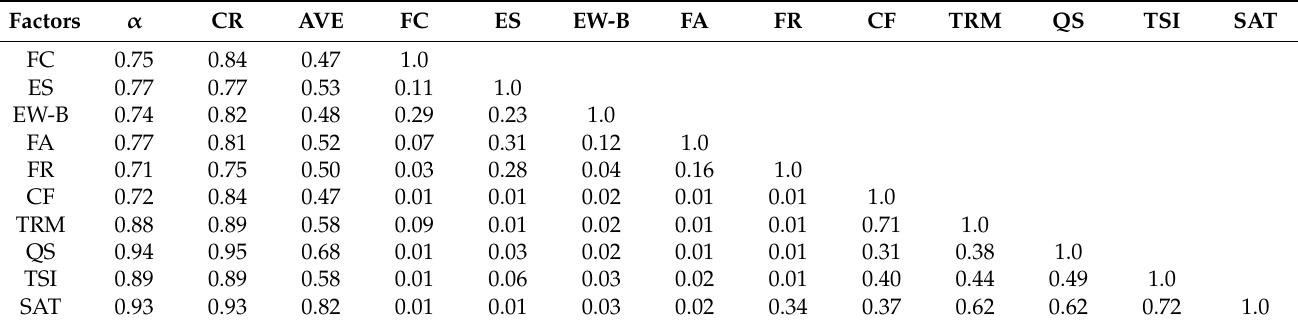
Table 2. Cronbach Alpha ( α ), composite reliability (CR), average variance extracted (AVE) and discriminant